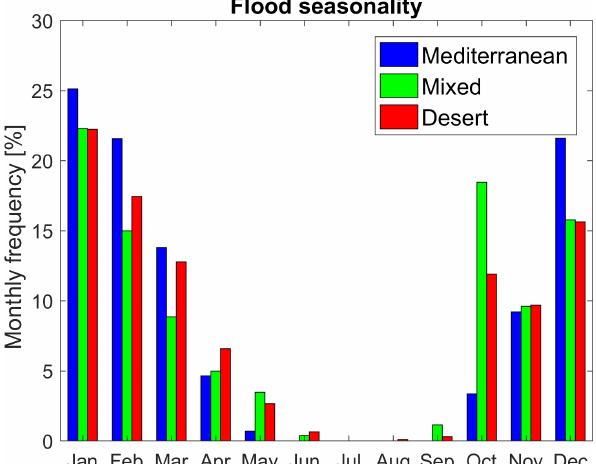
Figure 3. Monthly distribution of floods in the climatic